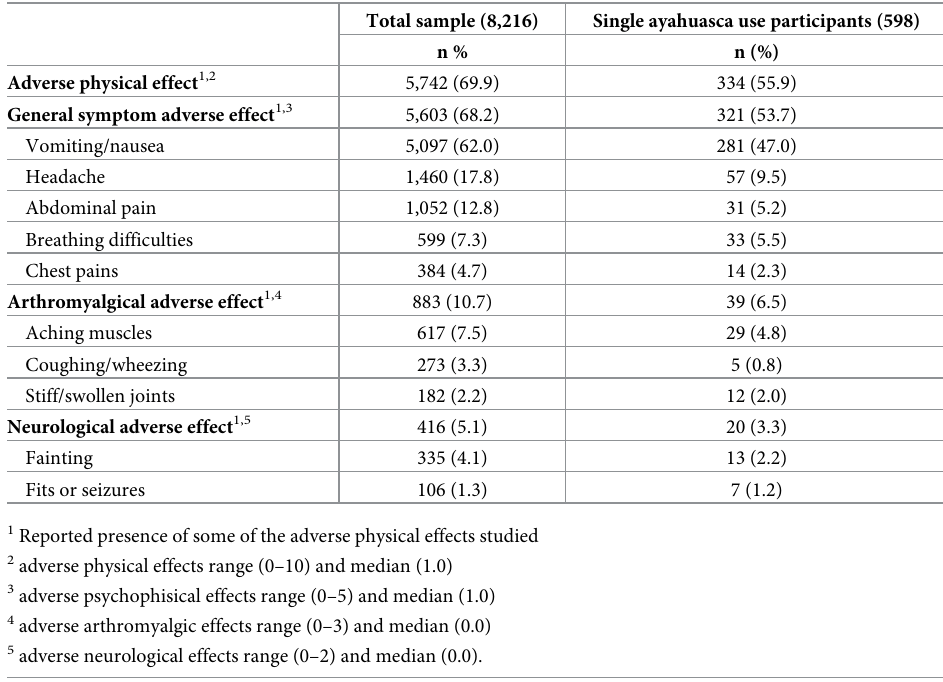
Table 2. Frequency of participants’ reported adverse physical effects (n = 8,216). Total sample